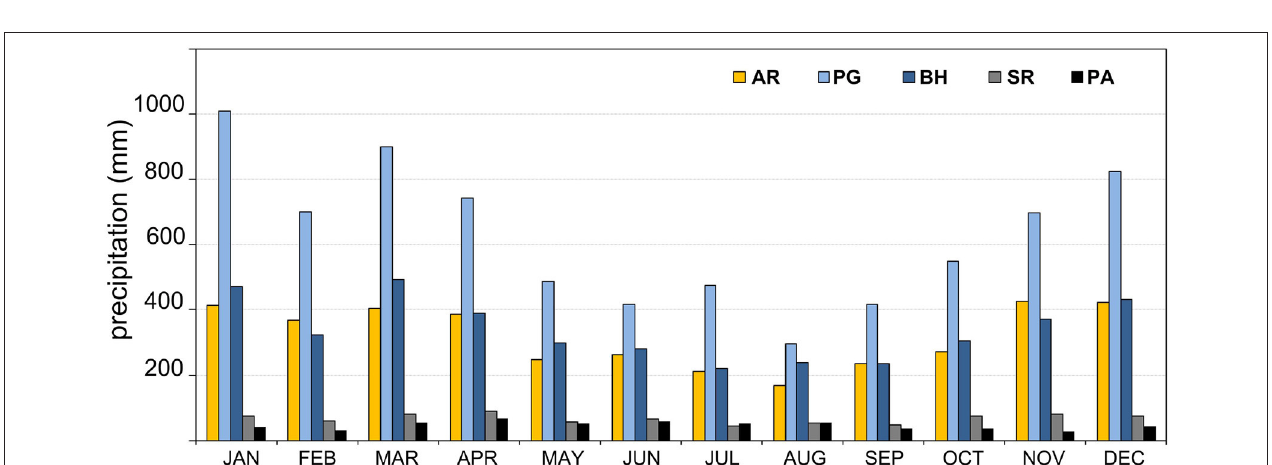
FIGURE 6 | Mean monthly precipitation AWS Arévalo (AR) (2008-2016), AWS Paso Galería (PG), AWS Puerto Bahamondes (BH), AWS Skyring (SR), and WS Punta Arenas (PA). Values were averaged from 2000 to 2016.